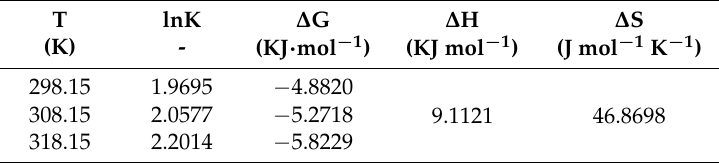
Table 2. Thermodynamic parameters of Hg 2+ adsorption on